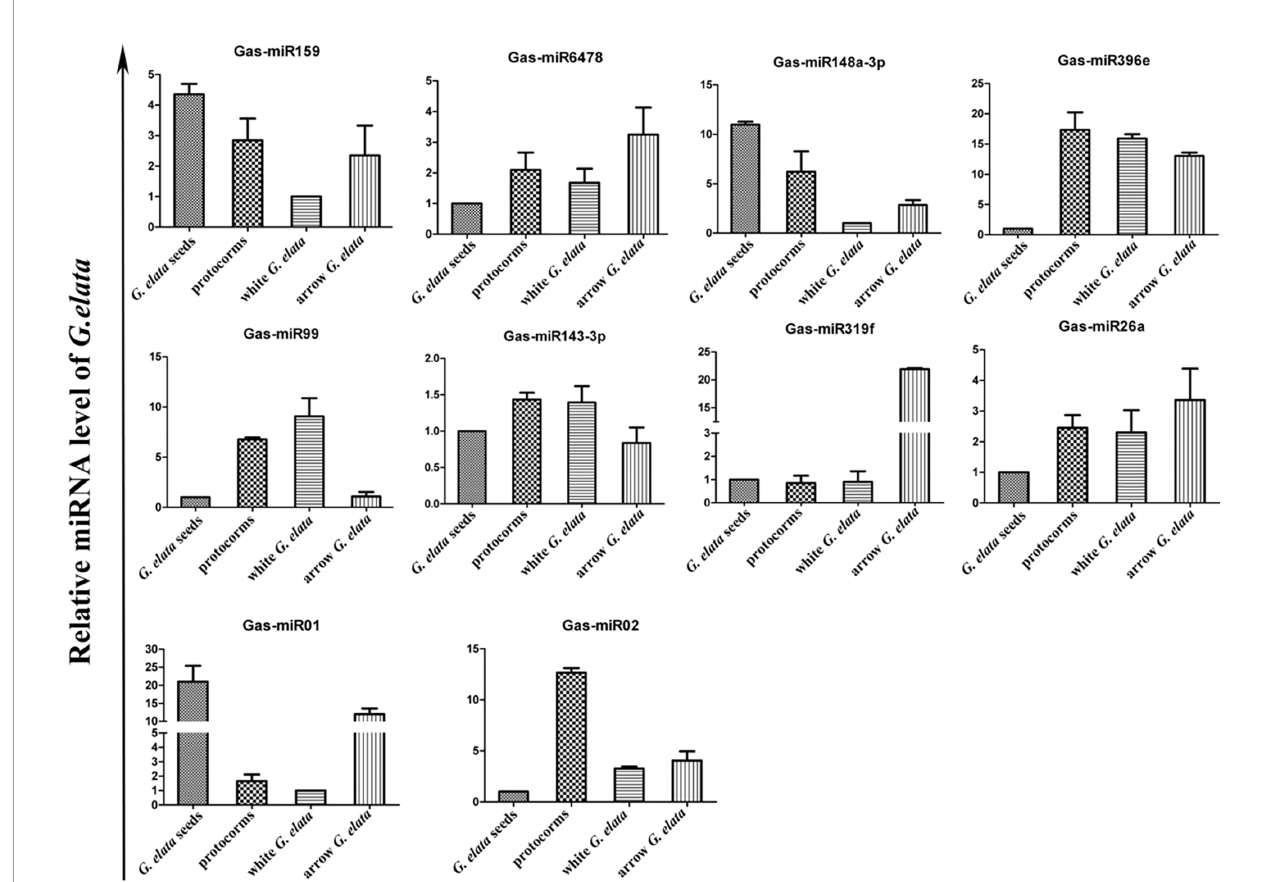
FIGURE 3 | Expression pro fi les of 10 G. elata miRNAs in different growth stages. The relative G. elata miRNA expression levels in different growth stages were determined by qRT-PCR. The vertical coordinate means fold